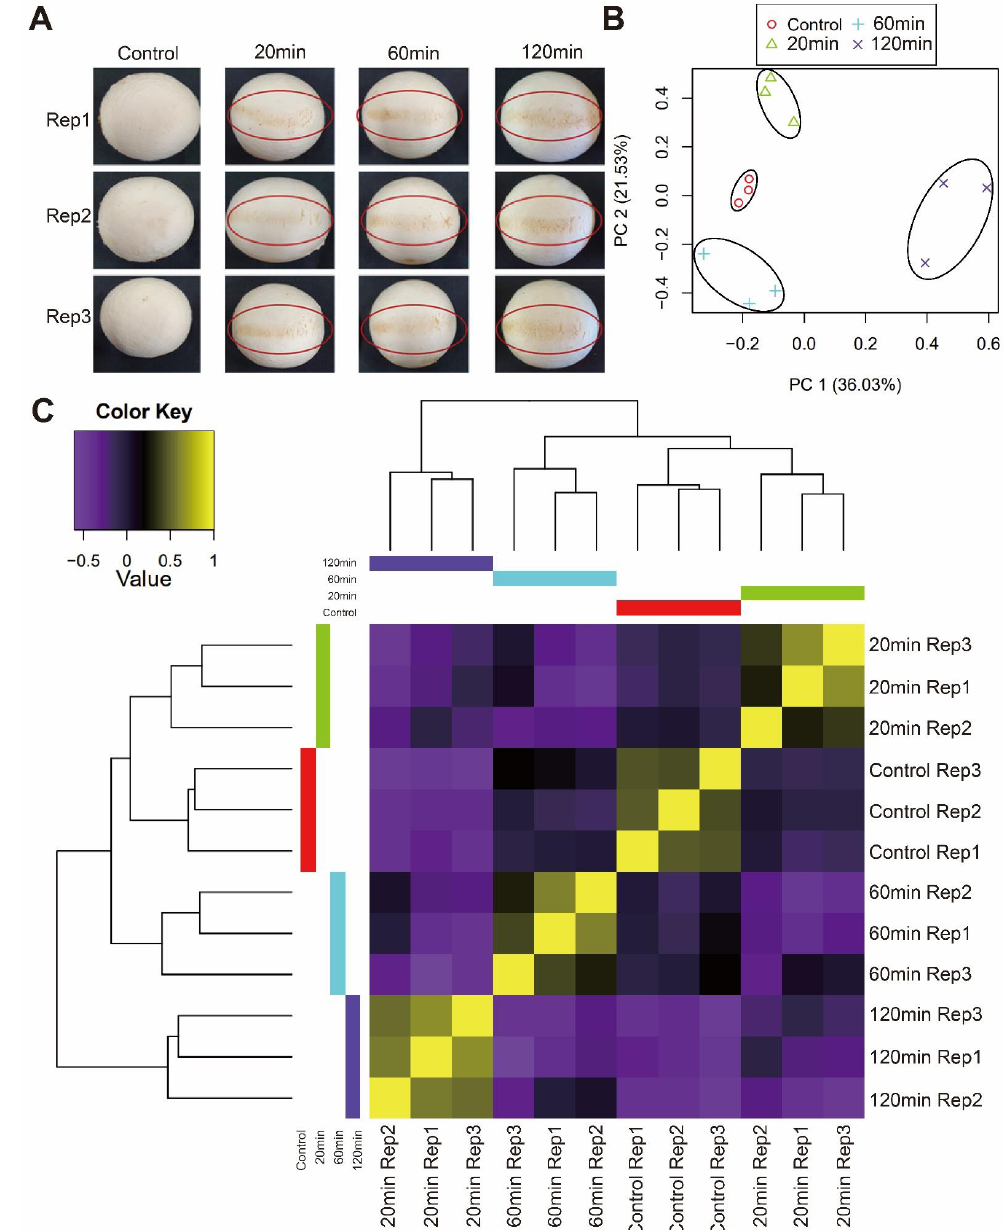
Figure 2. Transcriptome analysis of A. bisporus strain KMCC00540 with mechanical stimulus. ( A ) Phenotype of mechanical stimulus-treated A. bisporus after 20, 60, and 120 min. ( B ) Principal component analysis (PCA) and ( C ) hierarchical clustering analysis by time after mechanical stimulus. The repetitions of each time and control are